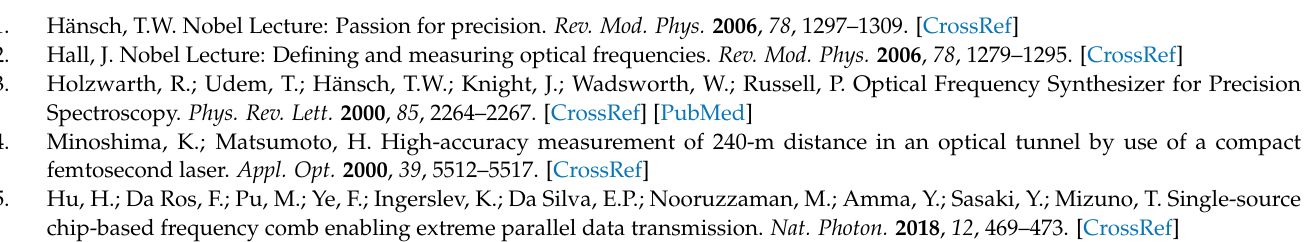
ewidth for OFC with FSR of 6.25 GHz and 3.125 GHz (ESA resolution 30 Hz). for OFC with FSR of 6.25 GHz and 3.125 GHz (ESA resolution 30